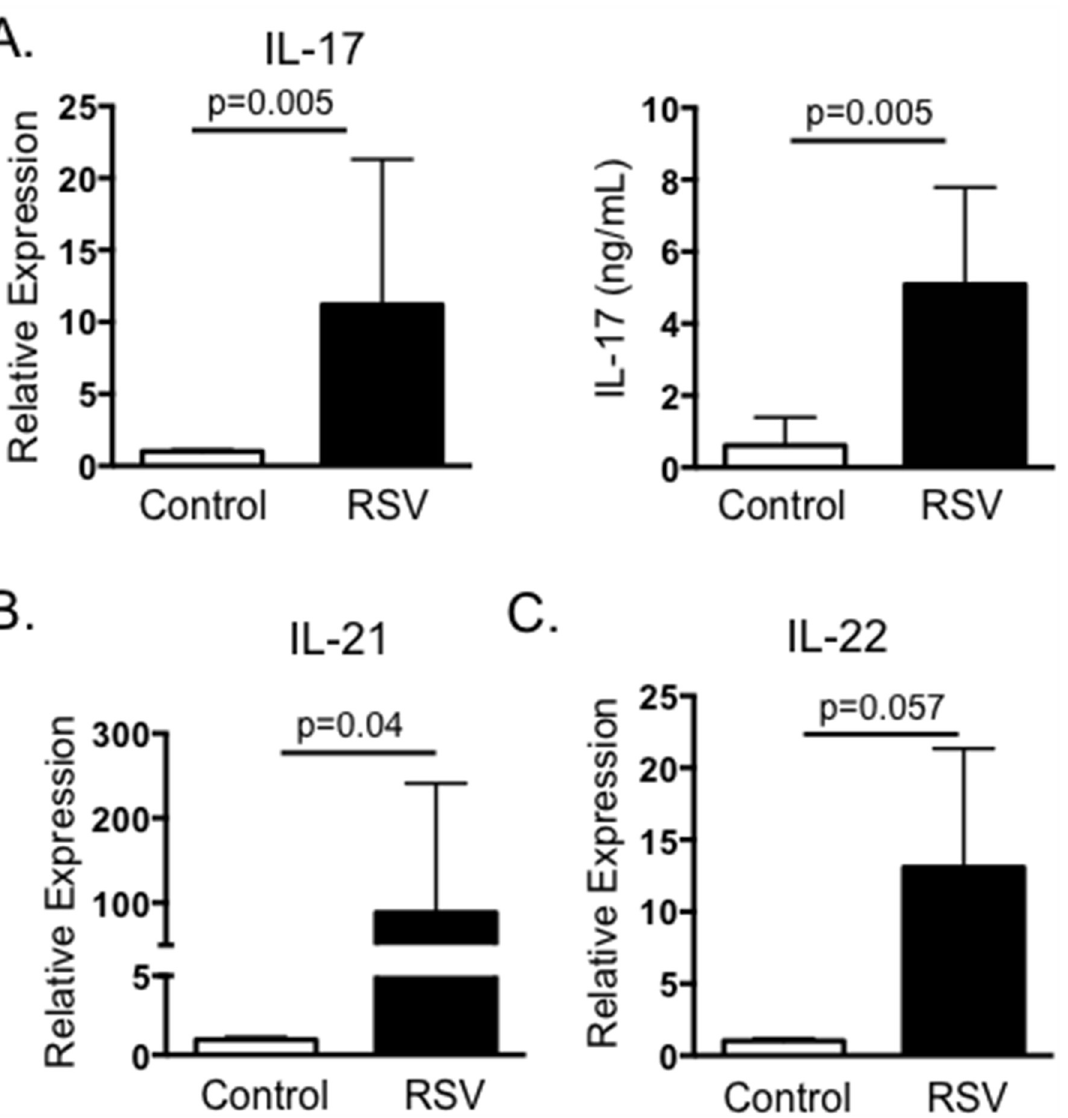
Fig 2. IL-17 and Th17 responses from BRSV vaccinated cattle. Peripheral blood was collected from cows receiving annual vaccinations with a multivalent vaccine containing live-attenuated BRSV (n = 8), or from control cows that were not included in the vaccination program due to inclusion in another study (n = 6). PMBC were isolated and stimulated with BRSV for 24 hours or 6 days, as in Fig 1. RNA was isolated from the cells and analyzed by qPCR for expression of IL-17 (A, left panel), IL-21 (B) and IL-22 (C). Cell culture supernatants were also analyzed by ELISA for IL-17 (A, right panel). For qPCR analysis, results were normalized to the housekeeping gene RPS-9, and expressed relative to unstimulated control samples. Results were pooled from two independent experiments. Data represent means ±